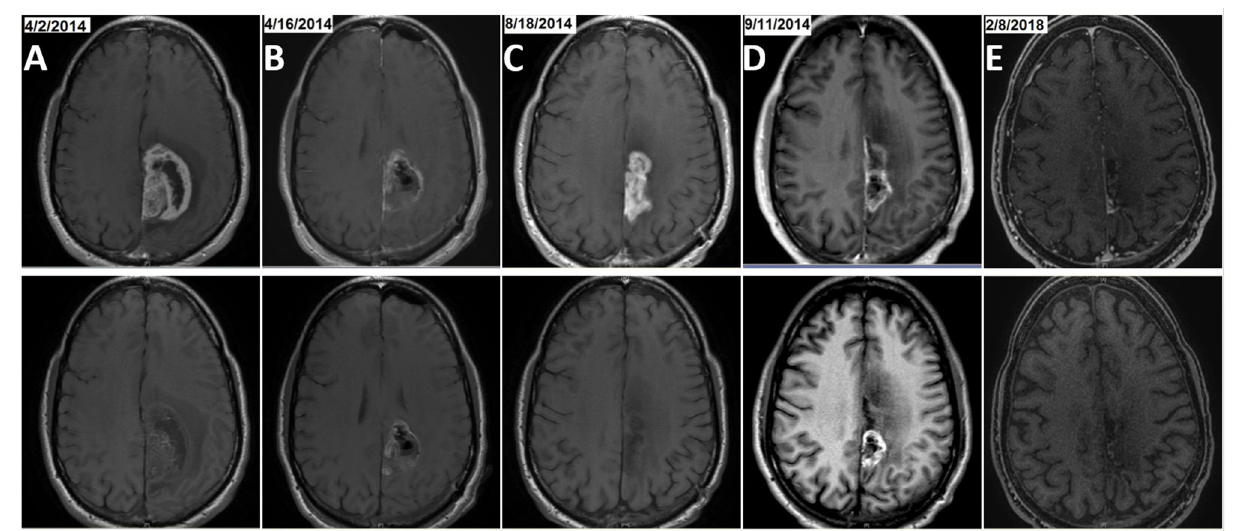
FIGURE 3 | Example of MRI results from patient number 3, a long-term survivor in the TBI + T group. The patient was treated with initial craniotomy and concurrent radiation and temozolomide followed with maintenance TMZ. He was treated with TBI (22 treatments with BEV and IRI from March 2015 to January 2016) after his first GBM progression (rGBM) was resected. The patient finished a cumulative 30 cycles of TMZ when the TBI regimen was completed and he continued on TTFields treatment alone for 39 months as of March, 31, 2018. Two craniotomy surgeries were performed in April and September of 2014, respectively. Pre- and post-craniotomy MRIs, T1 with contrast for newly diagnosed GBM [ (A) , 4/2/2014 and post-surgery at (B) , 4/16/2014] and rGBM [ (C) , 8/18/2014 and post-surgery at (D) , 9/11/2014] as well as the most recent brain MRI immediately prior to the data cut-off date [ (E) , 2/8/2018] are shown in upper row, with brain MRI T1 without contrast shown in the corresponding lower row.